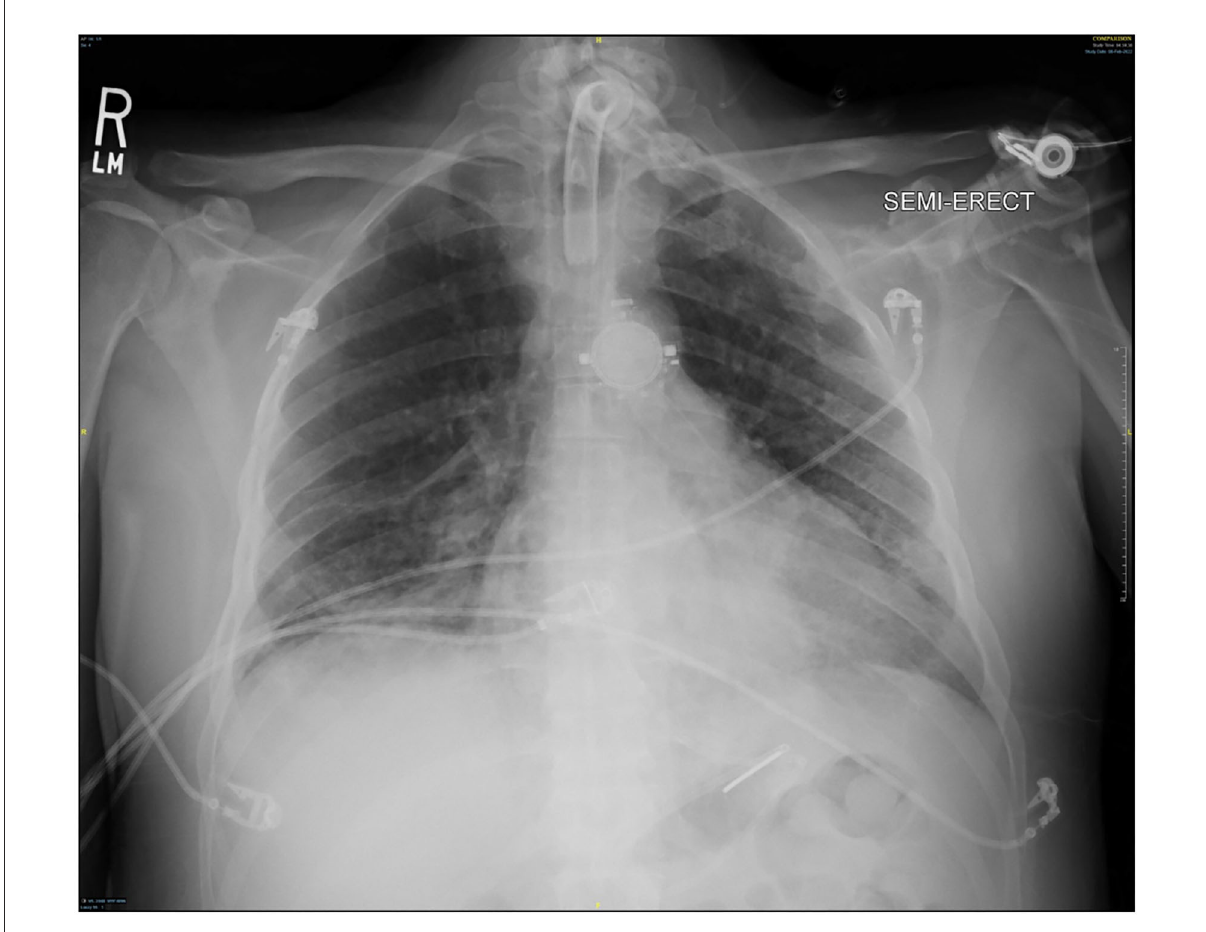
FIGURE7 Chest x-ray after ECMO